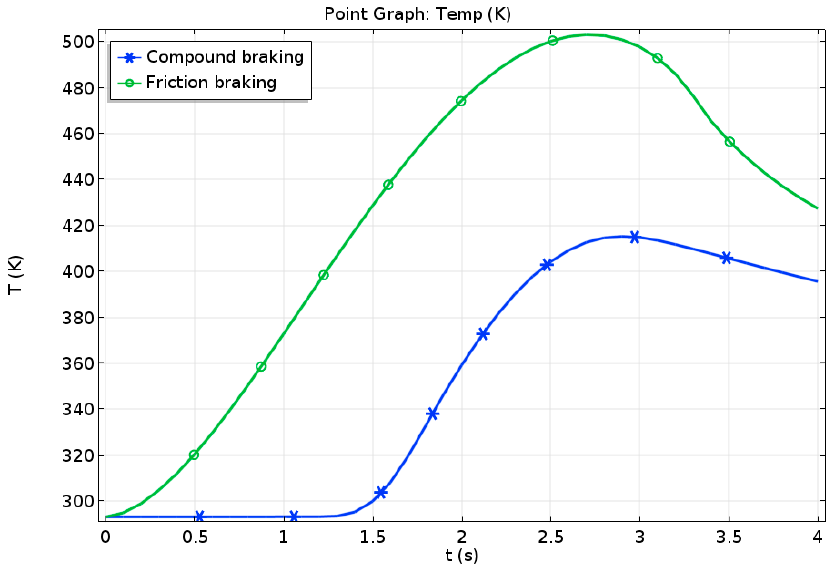
Figure 14. Contrast curves of temperature rise for two different braking forms.